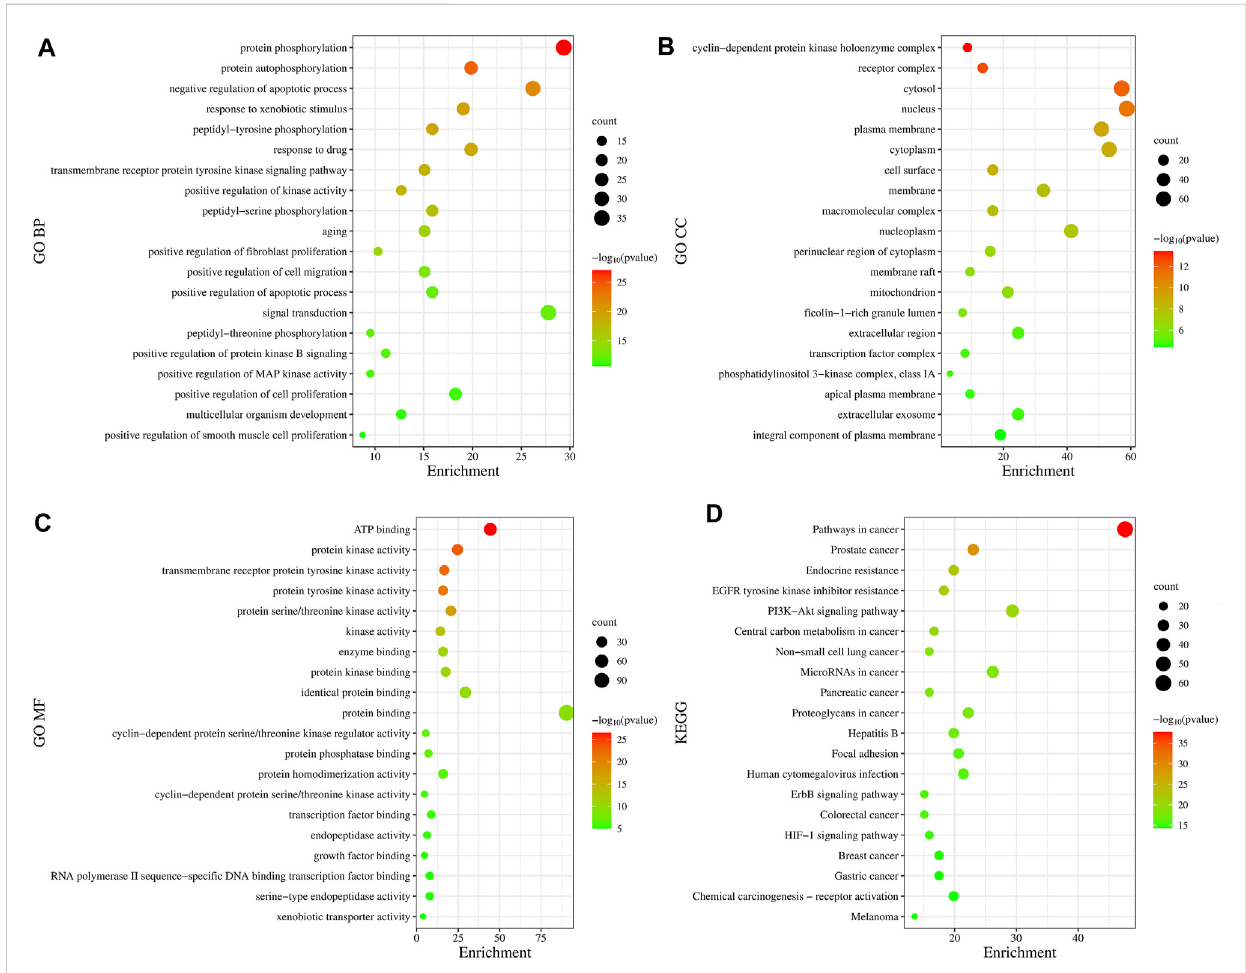
FIGURE 3 Gene Ontology functional and Kyoto Encyclopedia of Genes and Genomes pathway enrichment analyses. (A) Biological Processes. (B) Cellular Component. (C) Molecular Function. (D) KEGG analysis. The size of the dots represents the number of genes; the larger is the dot, the higher is the number of genes in the corresponding process. p values indicate the importance of enrichment; the lower is the p values, the redder is the color of the